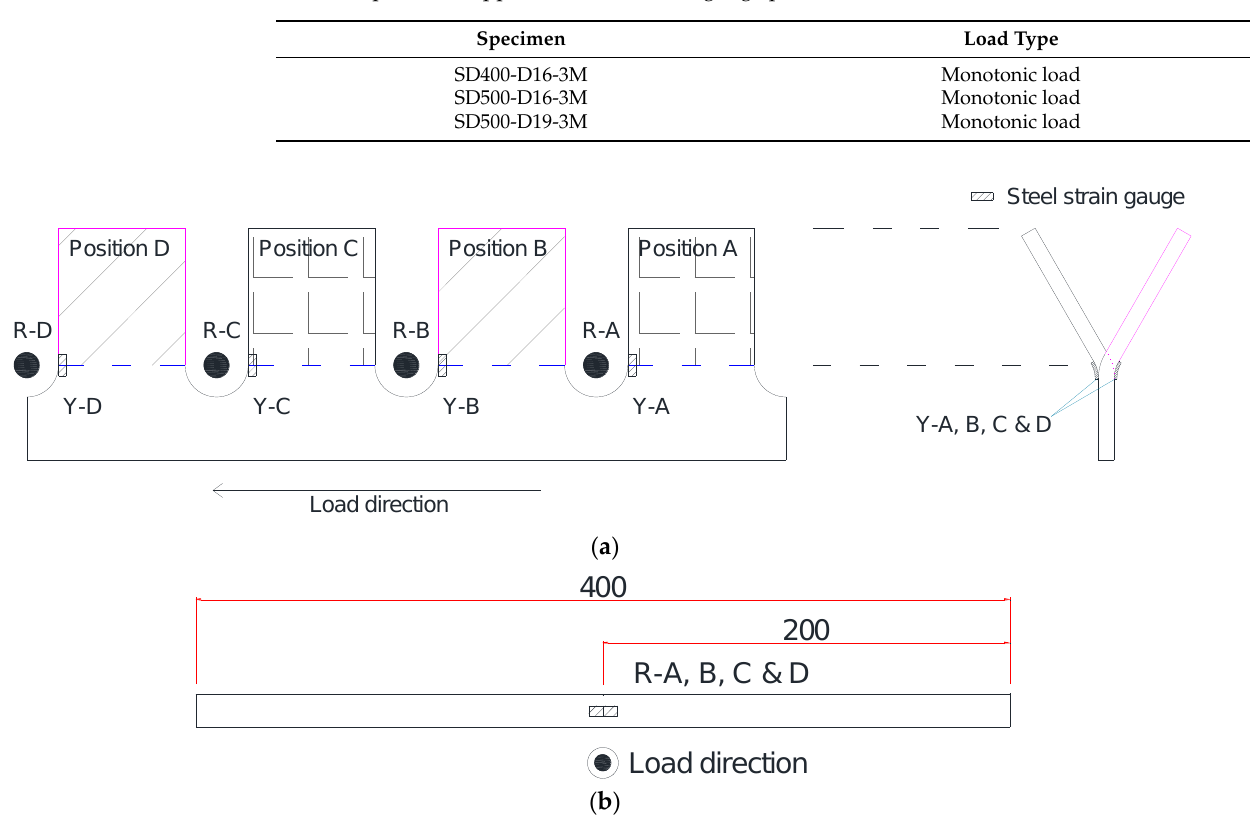
Figure 3. Specifications of points of steel strain gauges. ( a ) Points of steel strain gauges on a Y-rib and ( b ) points of steel strain gauges on a transverse rebar. Table 4. Specimens applied with the strain gauge plan.